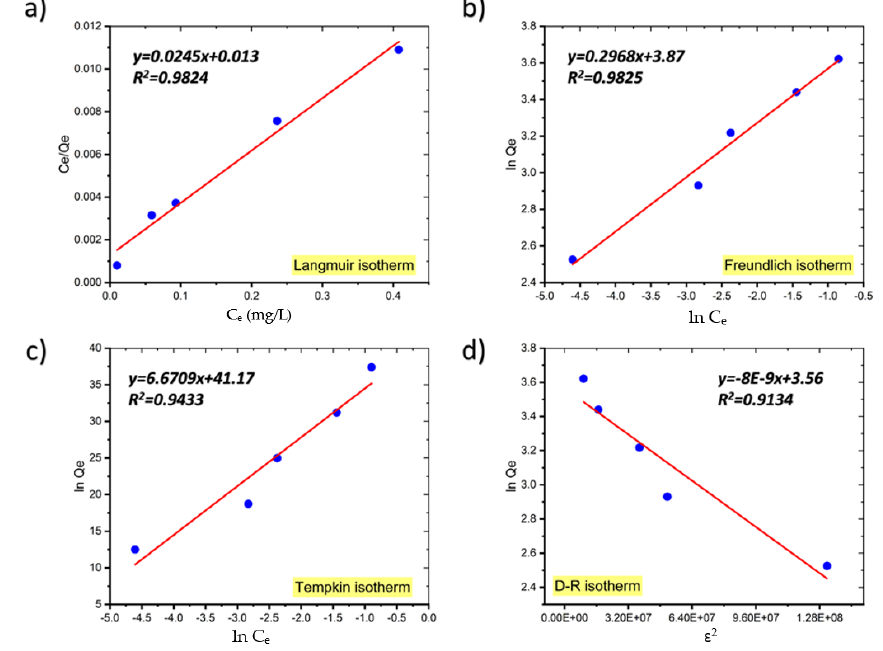
Figure 7. The Langmuir ( a ), Freundlich ( b ), Temkin ( c ), and Dubinin–Radushkevich ( d ) adsorption isotherm plots for the adsorption of MB onto coal.